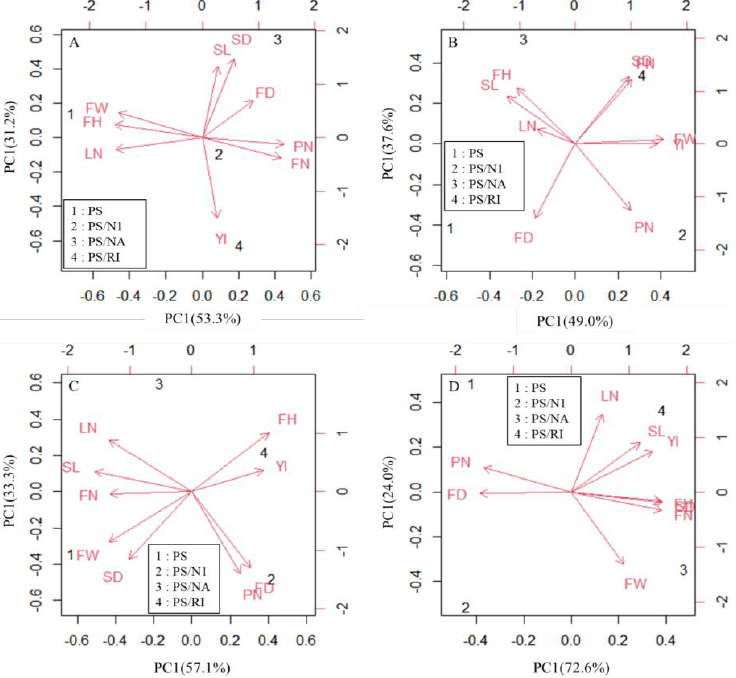
Figure 5. Biplot of the principal component analysis (PCA) of yield and growth of grafted spray type Rosa hybrida cv. Pink Shine between rootstock type in four seasons based on the data in Table 1 with cutting and grafted rose being identified by numbers 1 to 4 and yield and growth parameter being identified by abbreviation. ( A ): spring; ( B ): summer; ( C ): autumn; ( D ): winter. PS: cutting on rosa hybrida cv. Pink Shine; PS/N1: Rosa hybrida cv. Pink Shine (PS) grafted onto rootstock of Rosa multiflora cv. Hort. No. 1; PS/NA: PS grafted onto rootstock of Rosa canina cv. Natal brier; PS/RI: PS grafted onto rootstock of Rosa indica cv. Major. FD: flower diameter; FH: flower height; FN: no. of florets; FW: fresh weight; LI: light intensity; LN: no. of leaves; PN: No. of petals; SD: stem diameter; SL: stem length; TE: temperature; YI: yield of